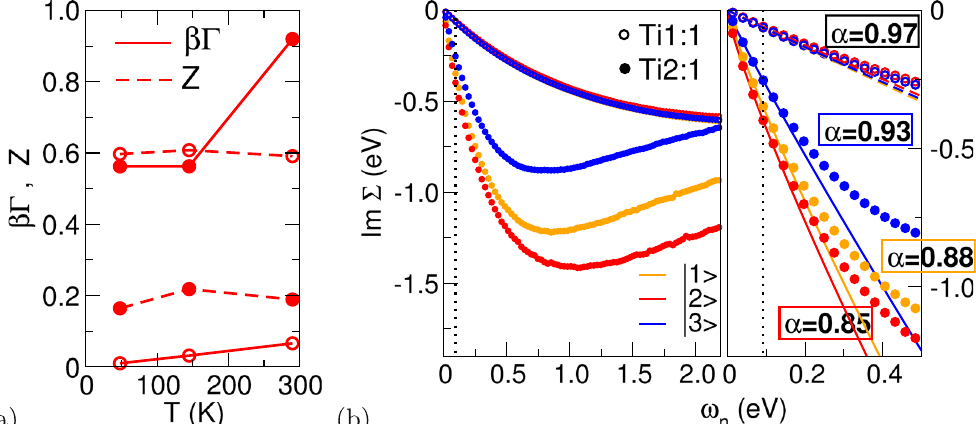
Figure 2. Transport analysis for both conducting layers. ( a ) QP weight and scattering rate for the |2 〉 state. ( b ) Orbital-resolved imaginary part of the self-energy on the Matsubara axis ω n = (2 n + 1) π T . Left: larger frequency range, right: low-frequency region with fitting functions Im Σ ( ω n ) = C 0 + ω α A fitting cutoff n c is denoted by the dotted line (for more details, see the Supplementary